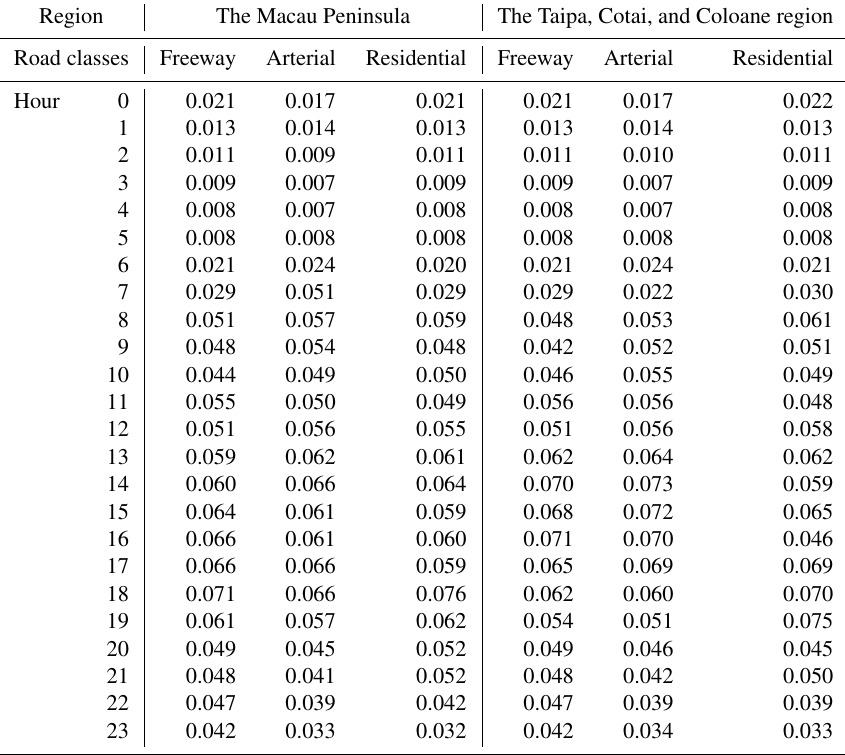
Table 1. Twenty-four hour allocations of total traffic counts by region and road class during weekdays in Macau in 2010. Region The Macau Peninsula The Taipa, Cotai, and Coloane